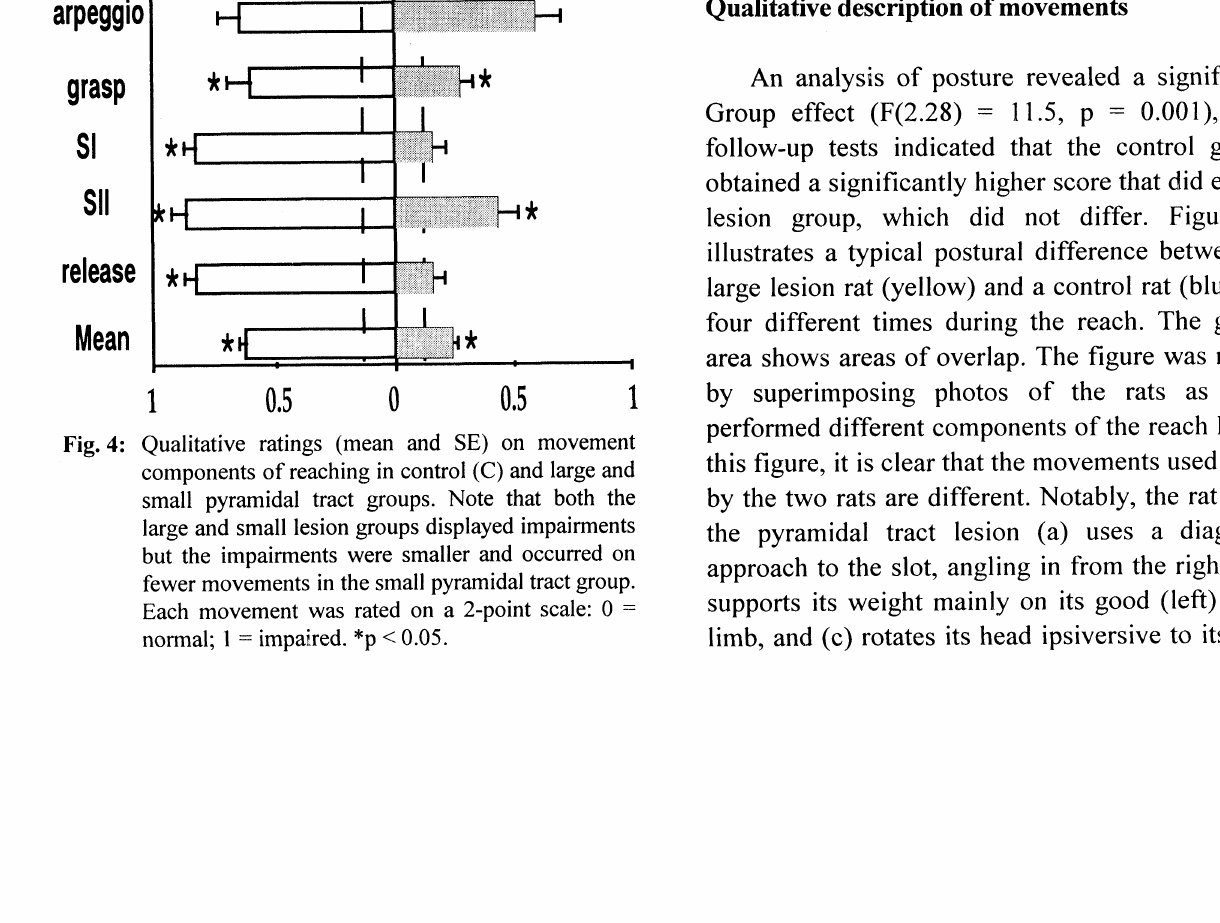
Fig. 4: Qualitative ratings (mean and SE) on movement components of reaching in control (C) and large and small pyramidal tract groups. Note that both the large and small lesion groups displayed impairments but the impairments were smaller and occurred on fewer movements in the small pyramidal tract group. Each movement was rated on a 2-point scale: 0 normal; impai, red. *p <